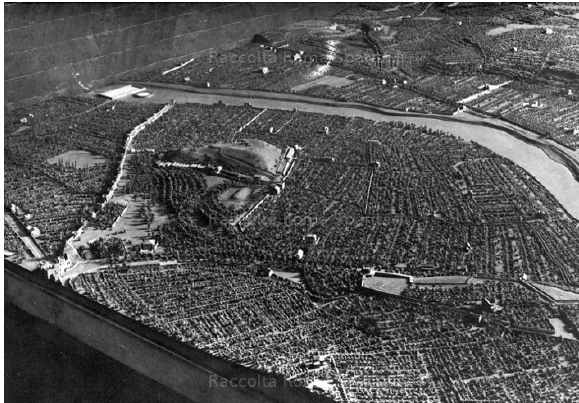
Figure 2. Model of the Testaccio area, 1849 ca. Used by the French army for the campaign of 1849. The external route of the river stretch of the Aurelian Walls and the internal route to protect the fields are highlighted. From the photographic archive of Roma Sparita